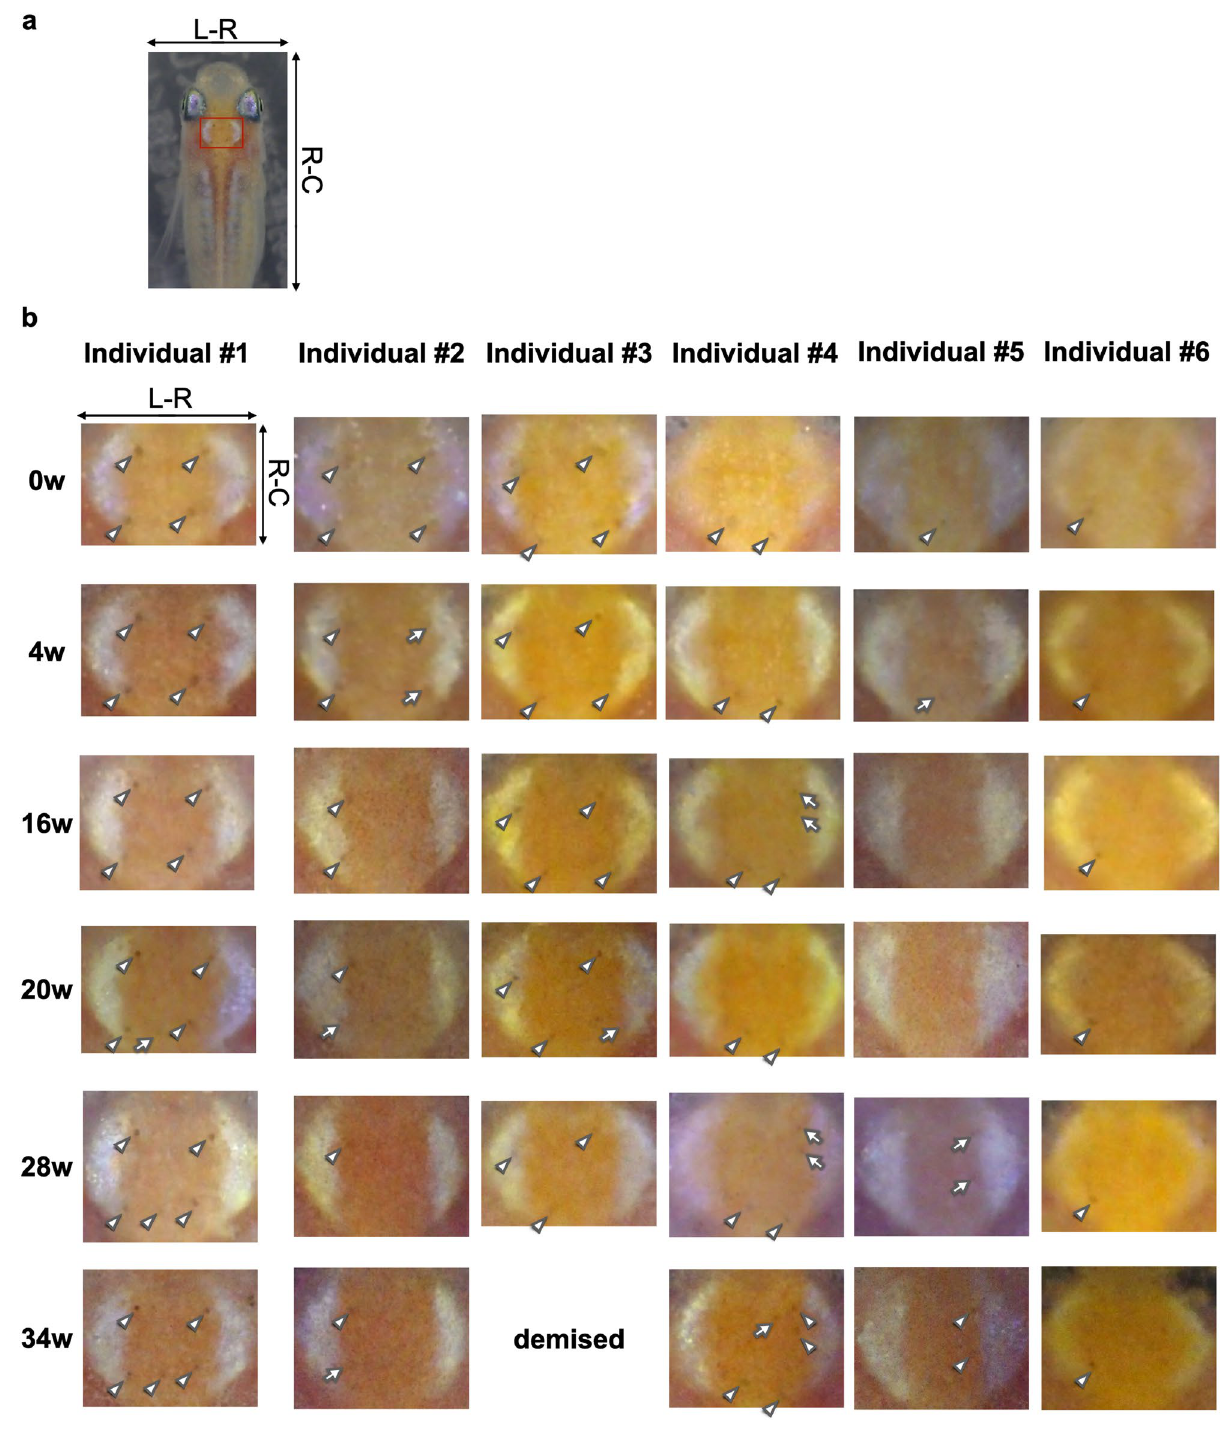
Figure 1. Extracted position of a mesencephalic region and its enlarged images of a mesencephalic region of six adult inbred medaka consecutively acquired at six time points. ( a ) Representative position of a mesencephalic region in the whole body. The extracted mesencephalic region (Individual #1, 0w) is shown as a red rectangle. ( b ) Enlarged images of an extracted mesencephalic region. Each column corresponds to individual medaka (Individual #1–#6), and each row to a single time point (0, 4, 16, 20, 28, and 34 weeks after the first acquisition). Individual #3 was demised at the last time point. A white arrowhead points toward a discerned melanophore spot. A white arrow indicates an appearance change of a melanophore spot between two consecutive time points. The Hd-rR strain (F97) was used as inbred medaka. Individuals #3, #4, and #6 were male, and Individuals #1, #2, and #5 were female. R-C: rostral-caudal axis, L-R: left-right